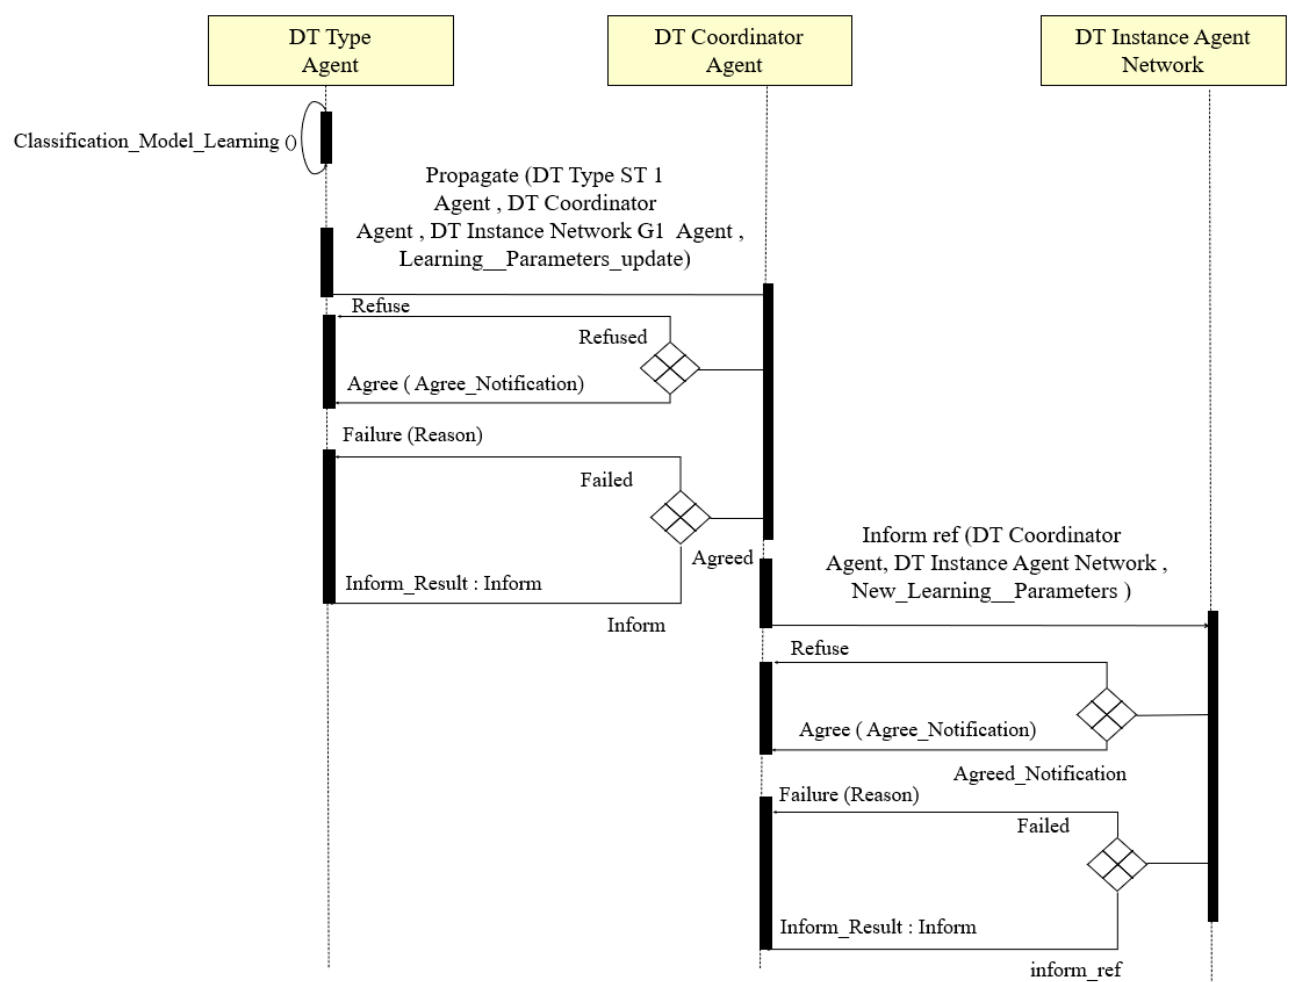
Figure 11. Protocol model for learning hyperparameters optimization.